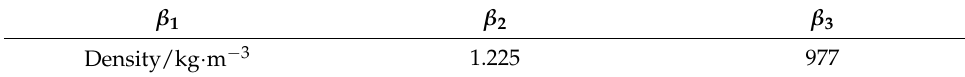
Table 5. Coefficients of the prediction model for the formed surface diameter. β 1 β 2 β 3